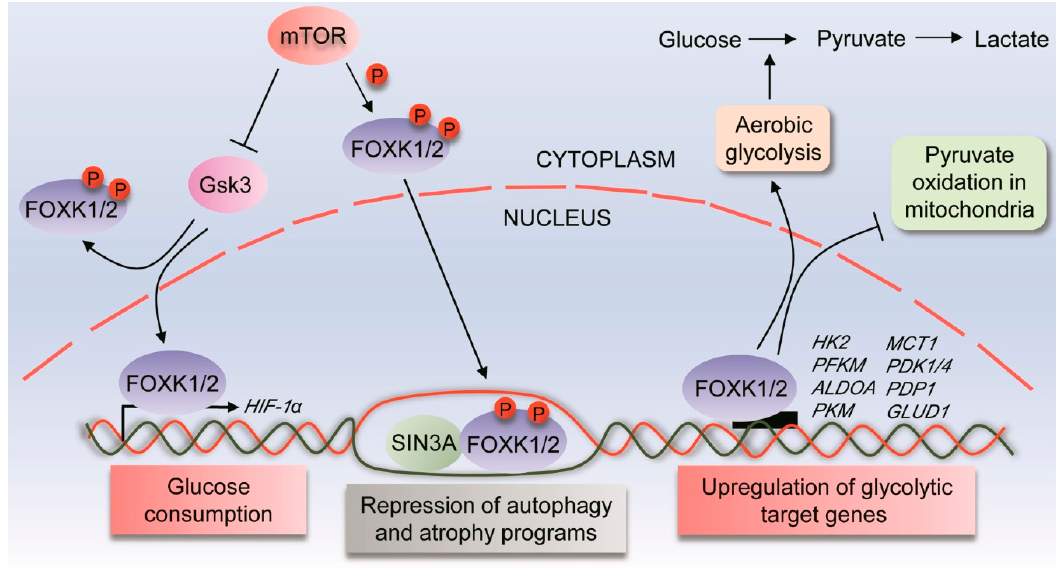
Figure 3. FOXK1/2 transcription factors in the control of metabolic processes. FOXK1/2 transcription factors are phosphorylated by mTOR, which translocate them to the nucleus where they interact with the Sin3A complex to suppress genes involved in atrophy and autophagy programs. Moreover, mTOR induces nuclear translocation of FOXK transcription factors through GSK regulation. In this context, FOXK1/2 induces HIF1 α gene expression and glucose consumption, contributing to cell proliferation. Additionally, FOXK1/2 regulate aerobic glycolysis while suppressing aerobic oxidation through the upregulation of glycolytic target genes. mTOR, mammalian target of rapamycin; Gsk3, glycogen synthase kinase 3; HIF1 α , hypoxia-inducing factor 1 alpha; SIN3A complex, SIN3